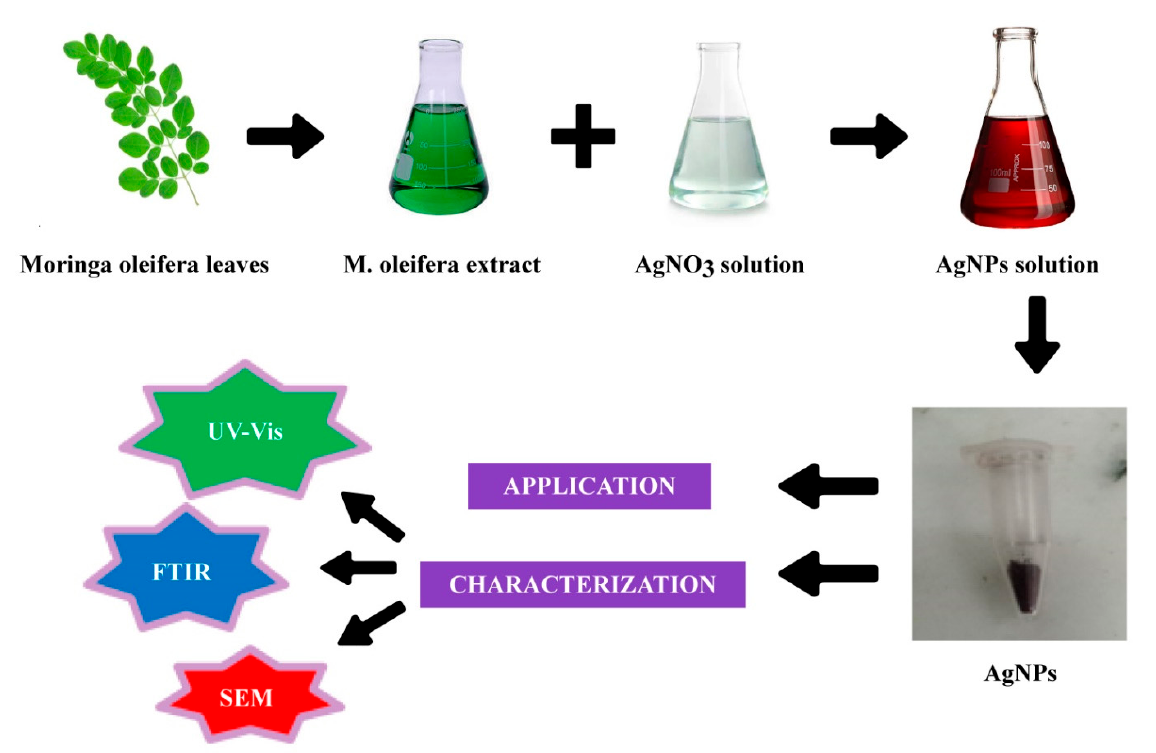
Figure 10. Methodology of green synthesis of silver nanoparticles.